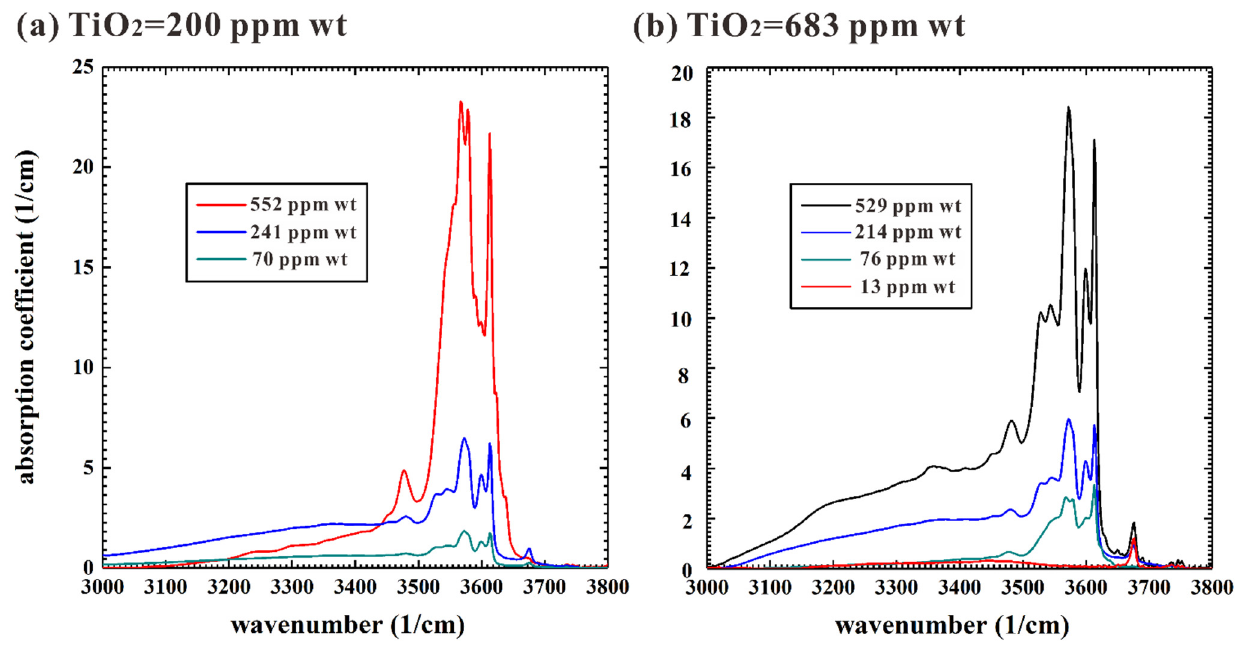
Figure 2. Representative FTIR spectra for hot-pressed sintering polycrystalline olivine aggregates within the wavenumber range from 3000 to 3800 cm ‒ 1 . Here, ( a ) displays a series of Ti-poor sample with three different water contents (552, 241, and 70 ppm wt); ( b ) displays a series of Ti-rich sample with four different water contents (529, 214, 76, and 13 ppm wt). The titanium content in polycrys- talline olivine aggregates (200 and 683 ppm wt) was precisely checked by the inductively coupled plasma mass spectrometry (ICP-MS) analysis in the Department of Earth and Planetary Sciences, Yale University (reproduced with permission from the reference of Dai and Karato [9]; published by the American Geophysical Union, 2020).